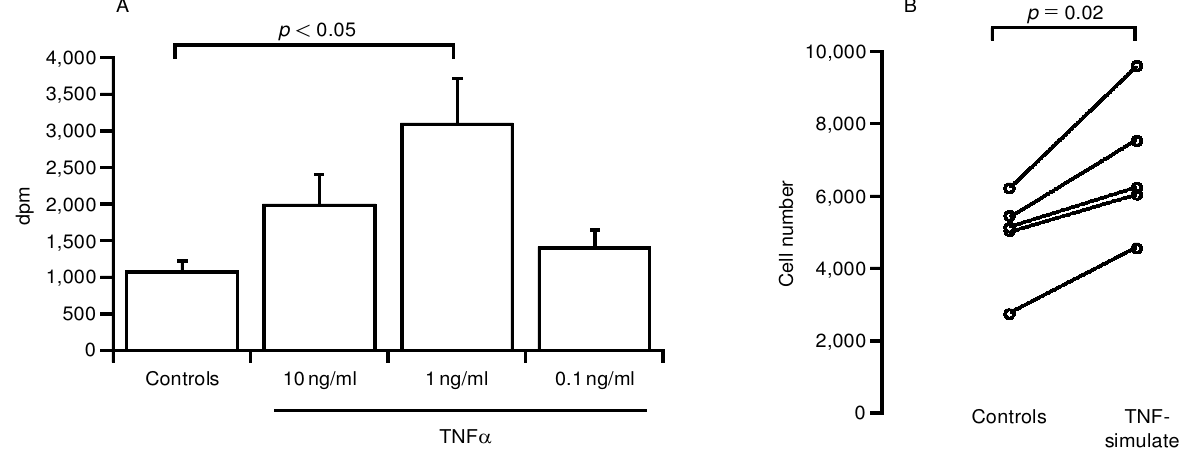
FIG. 1. Effects of TNF- a on the growth of human bone marrow stromal cells with 5% FCS in the culture medium. (A) Effects on [ 3 H]-thymidine incorporation: results (in dpm) are reported as mean SEM from four independent experiments each of six replicates. Data are compared with the Mann ± Whitney U-test. (B) Effects on cell counts: experiments were performed with cells from ® ve different donors. Data are compared with Student’s t-test for paired data.